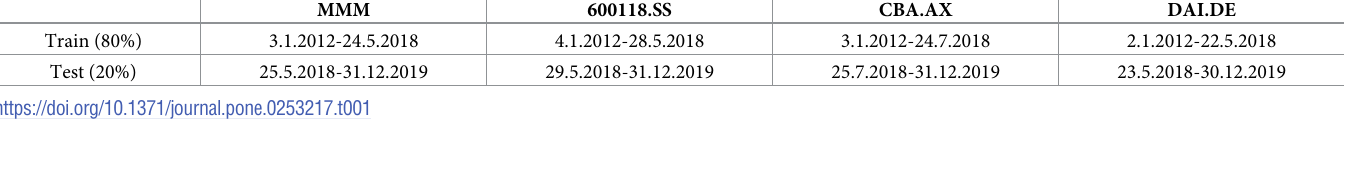
Table 1. Time span of data considered for each stock-price pre-COVID-19. MMM 600118.SS CBA.AX